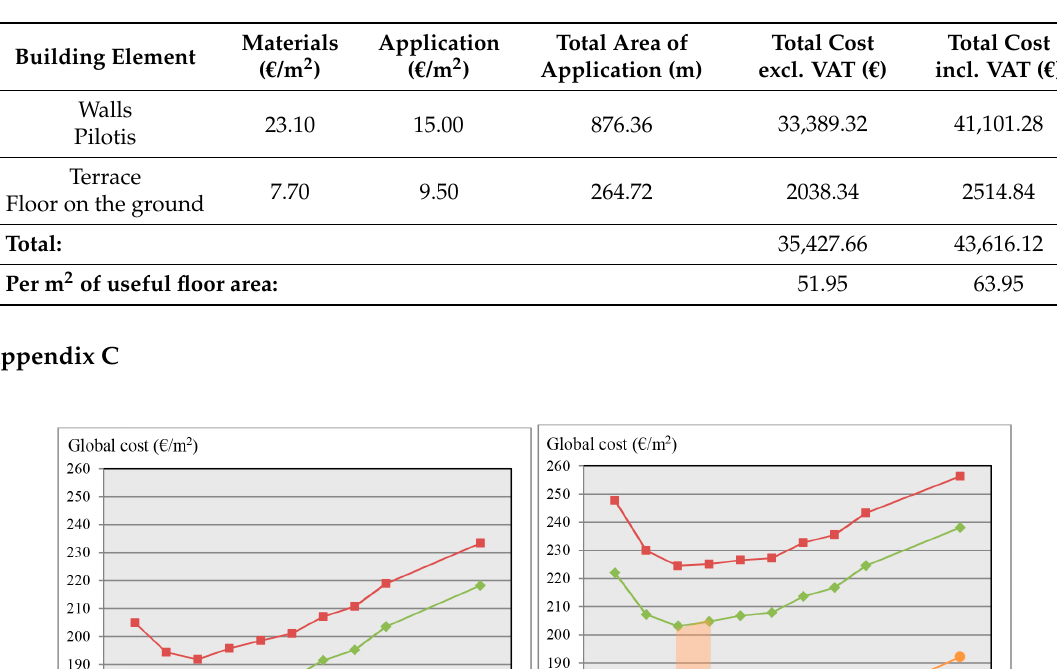
Table A3. Example of initial cost calculation for the 7 cm insulation scenario, with and without taxes.